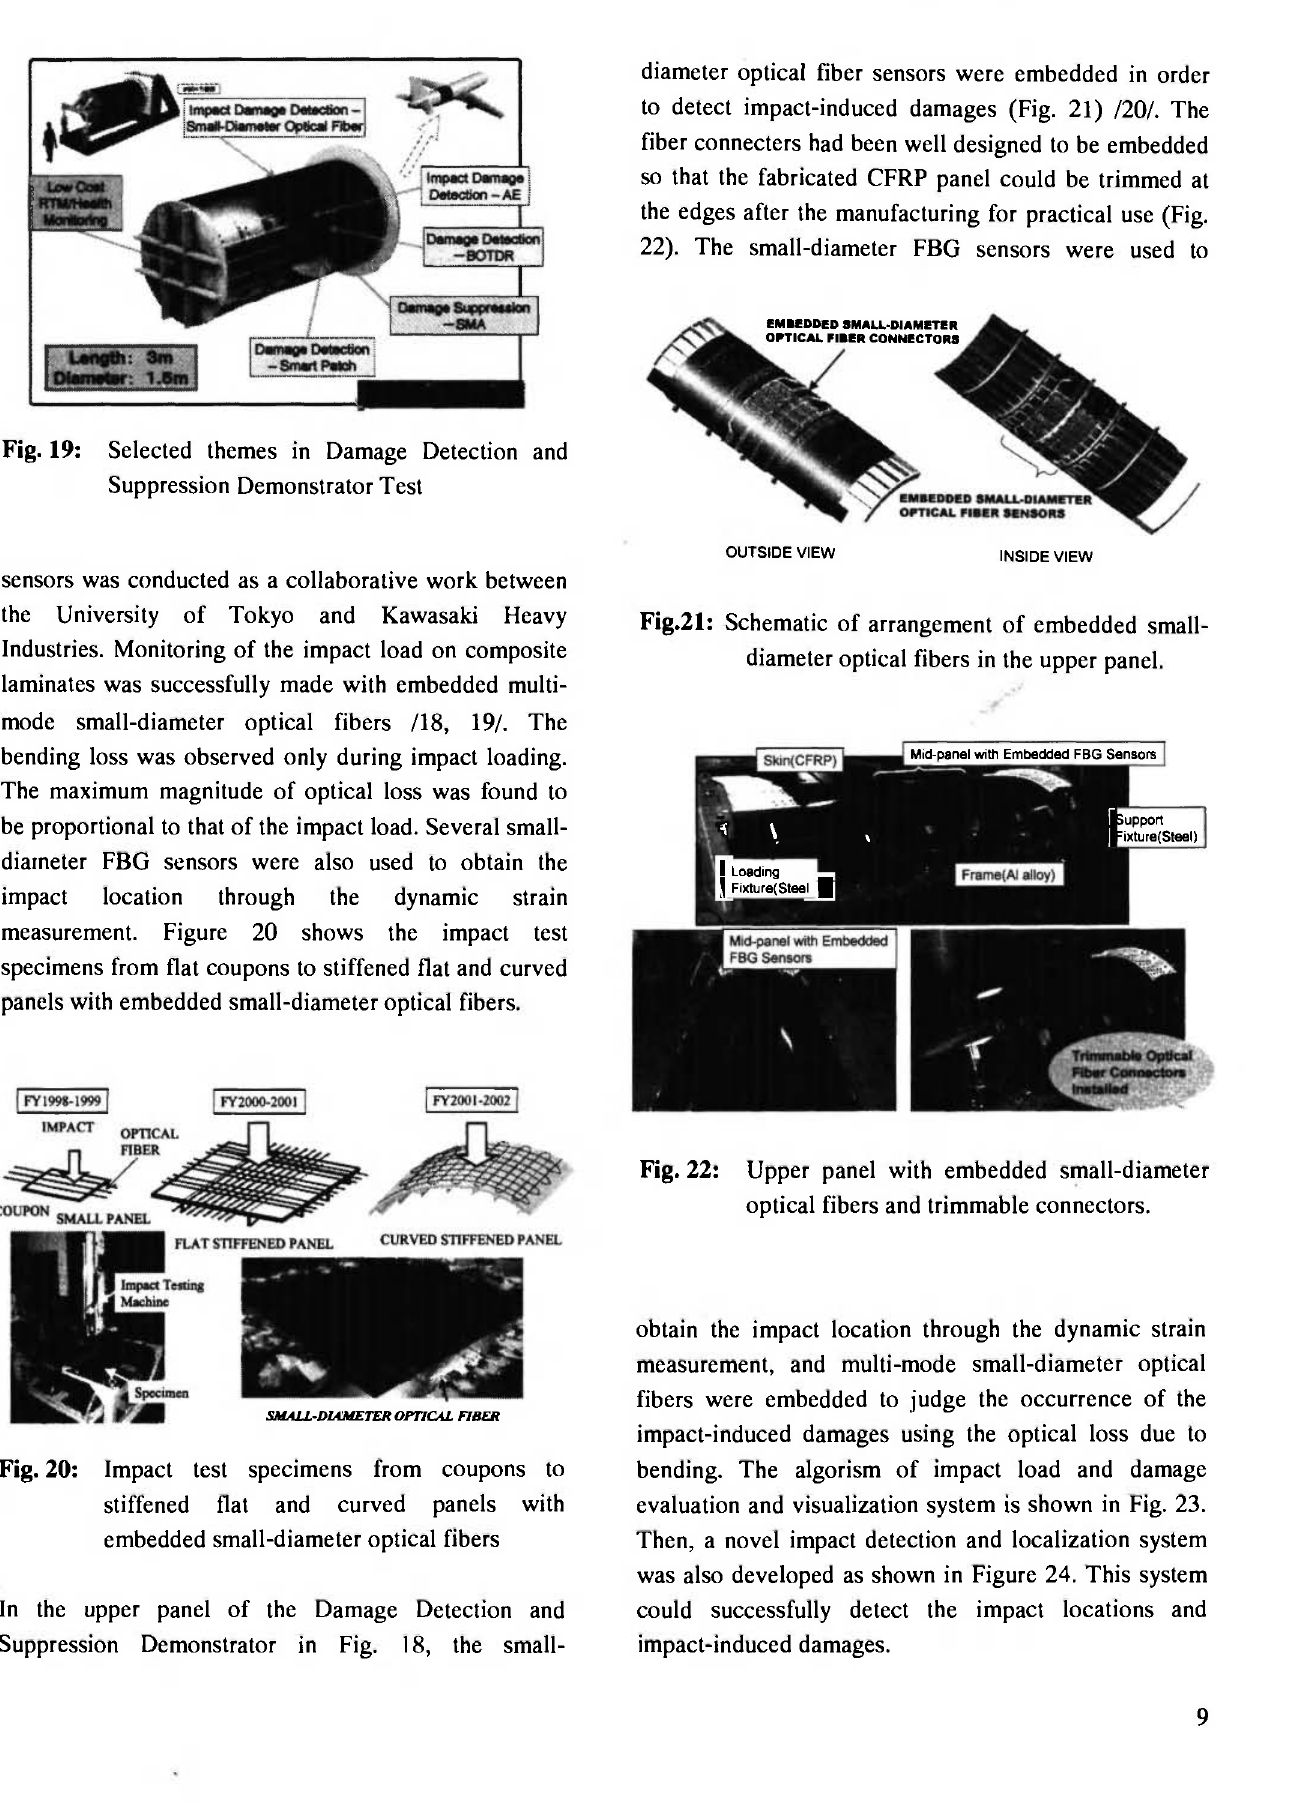
diameter optical fiber sensors were embedded in order to detect impact-induced damages (Fig. 21) /20/. The fiber connecters had been well designed to be embedded so that the fabricated CFRP panel could be trimmed at the edges after the manufacturing for practical use (Fig. 22). The small-diameter FBG sensors were used to